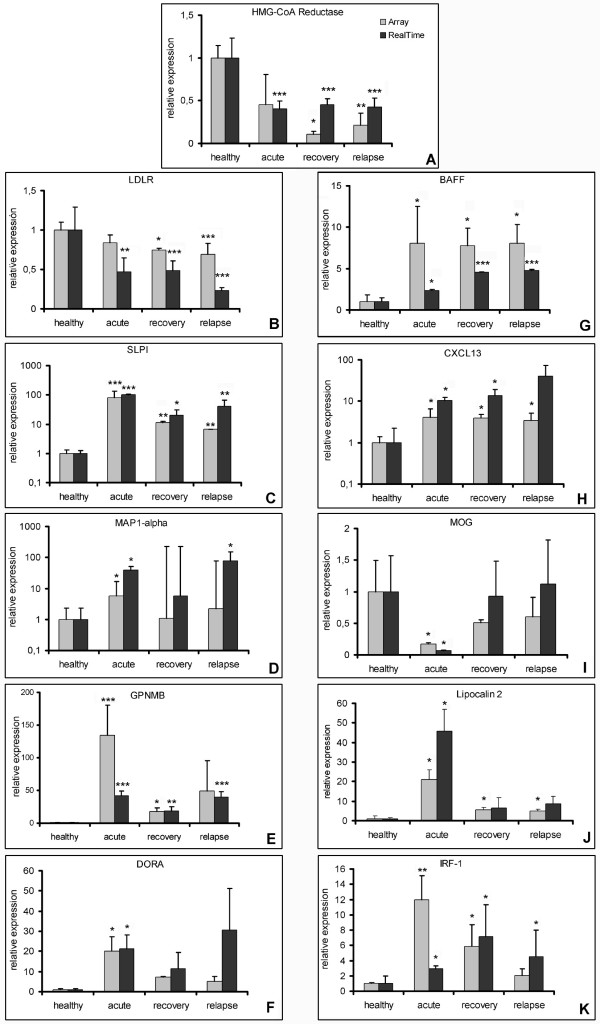
Confirmation of expression values obtained by microarray hybridization with RealTime-PCR values obtained from different samples others than those used for microarray hybridization but with comparable disease course (values are always normalised to quantity of 18S rRNA and presented + std dev, four animals per group) for following genes: A) HMG-CoA Reductase, B) Low density lipoprotein receptor (LDLR), C) Secretory leukocyte protease inhibitor (SLPI), D) MAP1alpha, E) Glycoprotein NMB (GPNMB), F) Downregulated by Activation gene (DORA), G) B cell-activating factor (BAFF), H) CXCL13, I) Myelin-oligodendrocyte-glycoprotein (MOG), J) Lipocalin 2 and K) Interferon-g regulated-factor-1 (IRF-1). The different disease phase were statistically compared using One Way ANOVA analysis of variance (Holm-Sidak method):*:p < 0.05, **: p < 0.01, ***: p < 0.001.